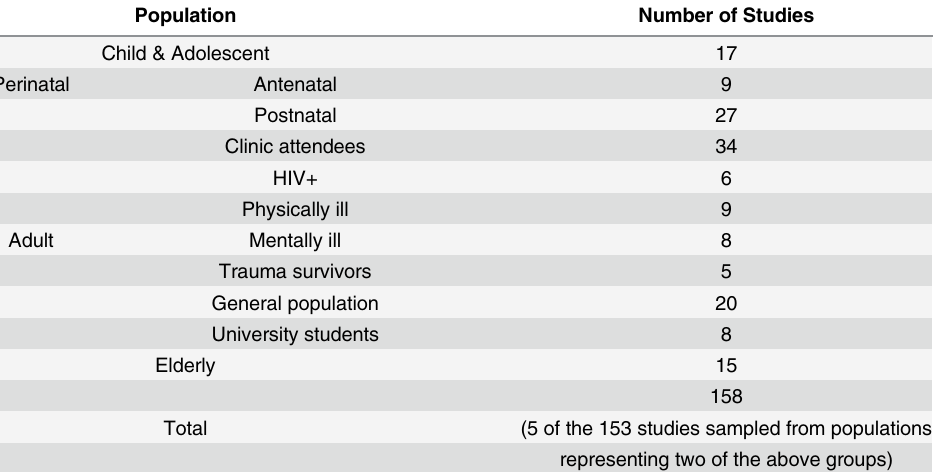
Table 3. Number of validation studies for each population